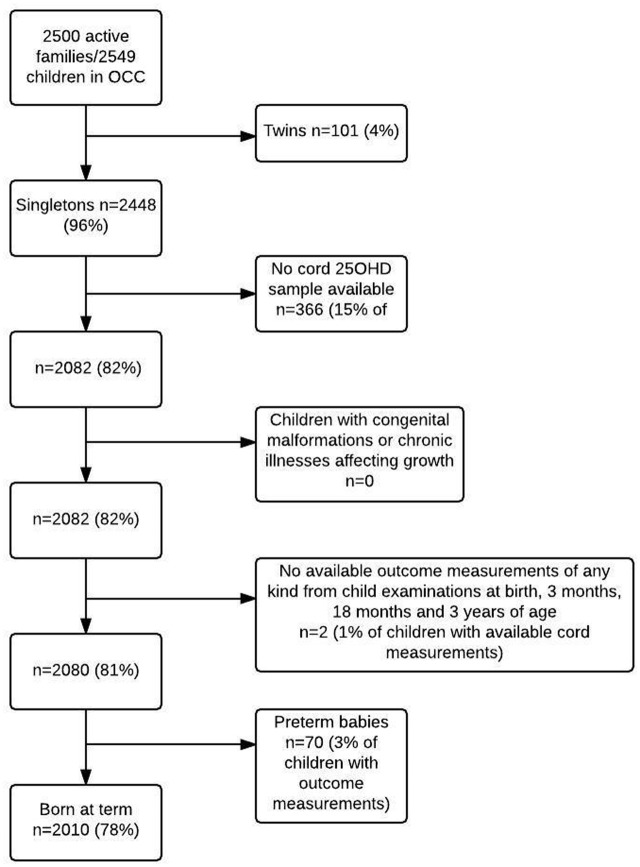
Flowchart of inclusion of 2010 participants from the Odense Child Cohort.Including healthy singletons born at term. Abbreviations: 25OHD: 25-hydroxyvitamin D.